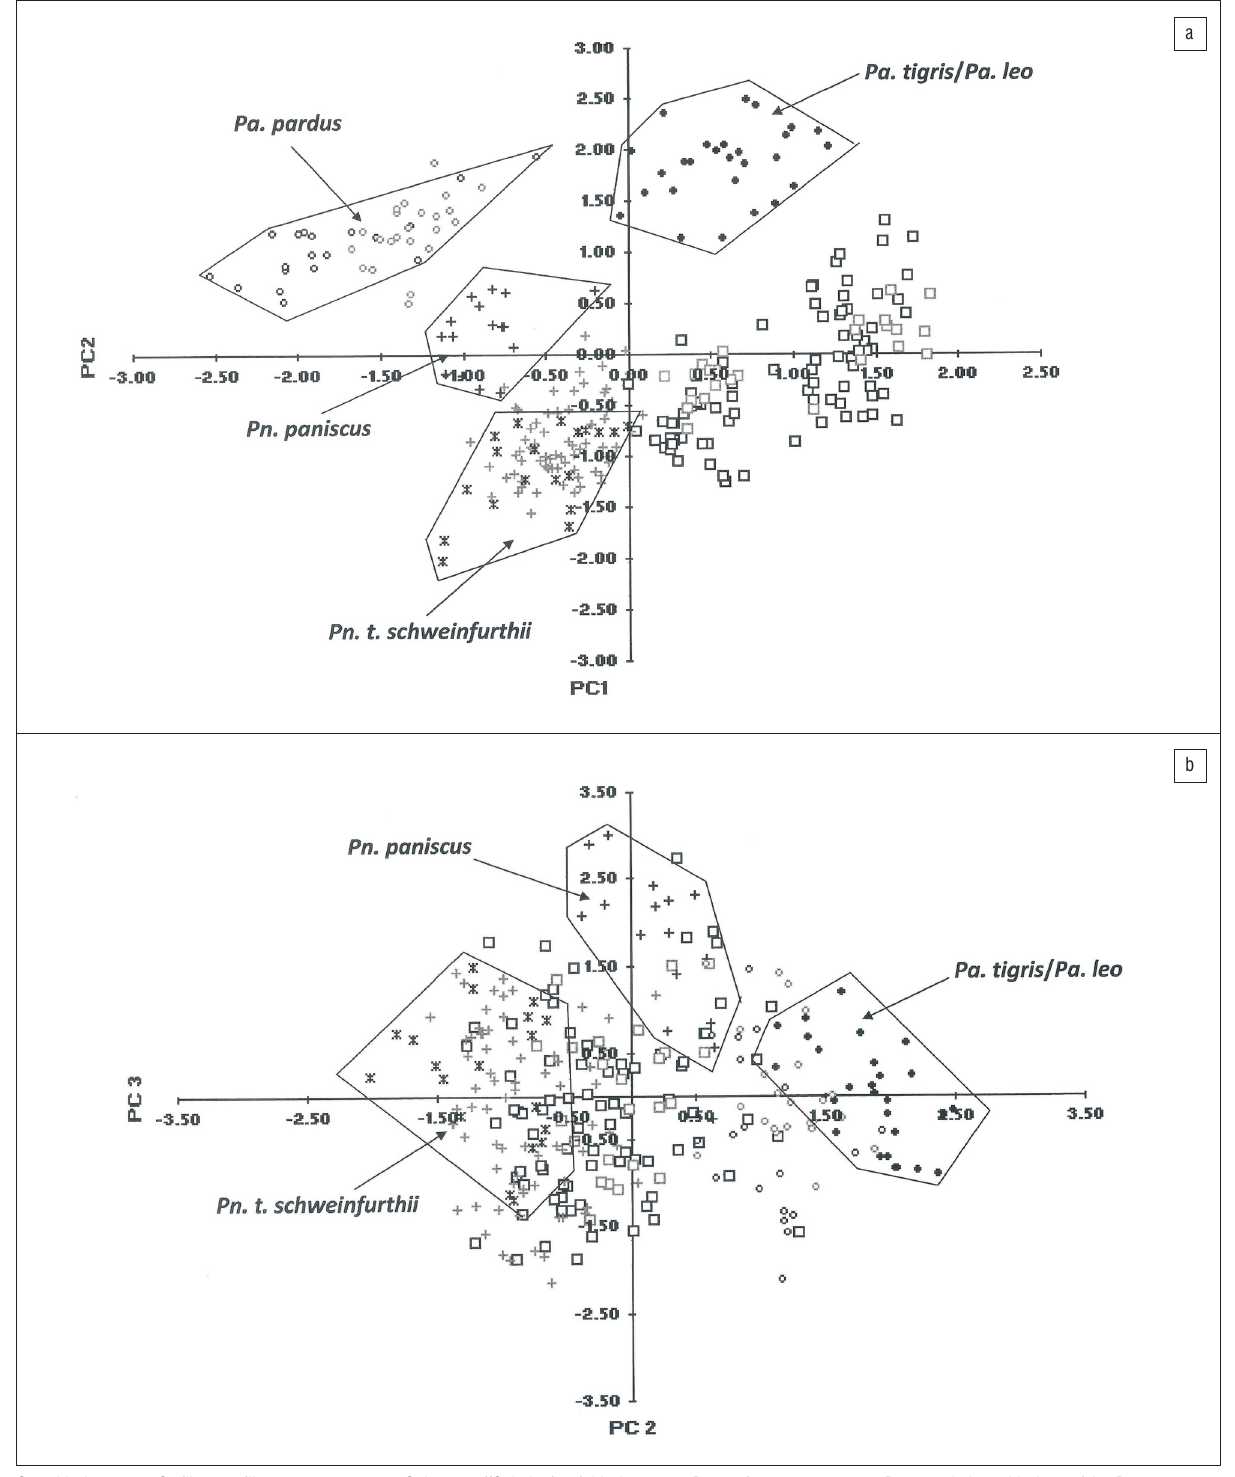
Open black squares, Gorilla g. gorilla; open grey squares, G. b. graueri/G. b. beringei; black crosses, Pan paniscus; grey crosses, Pn. t. troglodytes; black asterisks, Pn. t. schweinfurthii; filled black circles, Panthera tigris/Pa. leo; open black circles, Pa. pardus; open grey circles, A. jubatus. Figure 2: Principal components (PC) analysis of the pooled sample raw data: (a) PC2 to PC1 and (b) PC3 to